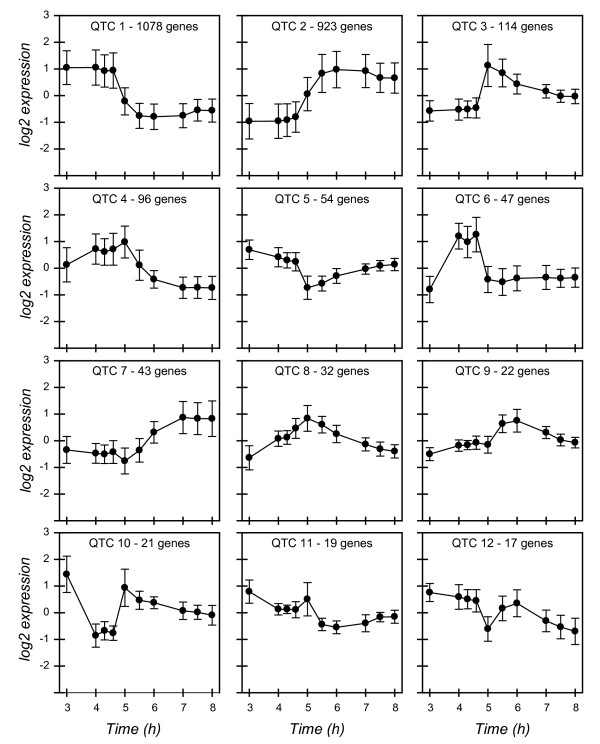
Quality Threshold (QT) clusters of the 2,552 ORFs with significant changes in gene expression. The number of ORFs in each cluster is listed at the top of each plot. Average expression profiles were determined for the ORFs in each cluster and plotted with the standard deviation for each time point.